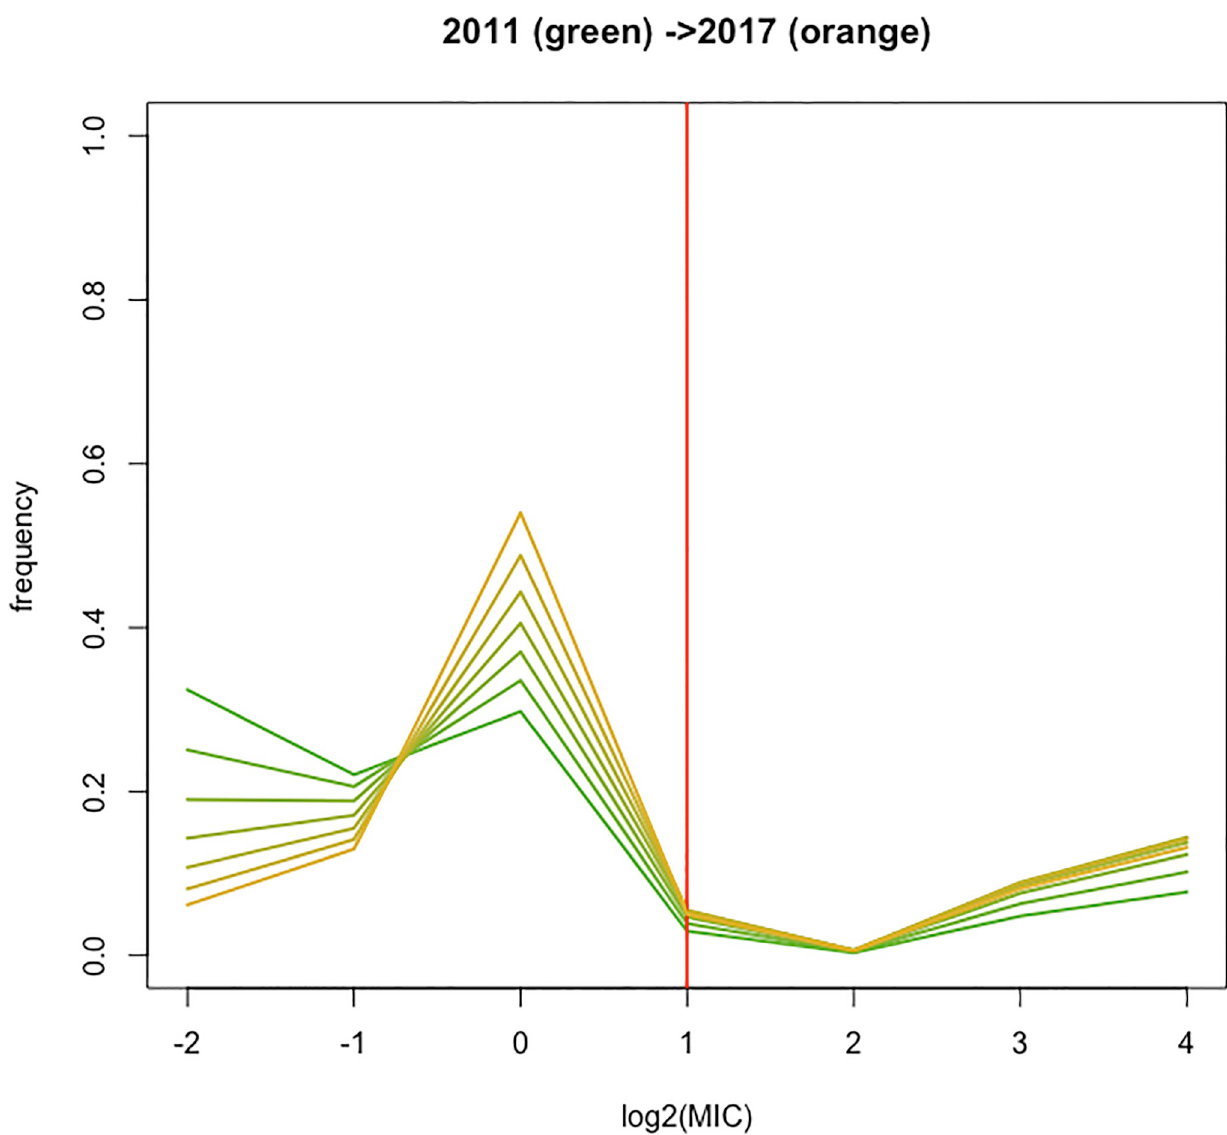
Fig 6. MIC distribution for the ISU VDL data. The observed and fitted MIC distribution, using the best fitting model 7, for each year. The vertical red line refers to the threshold